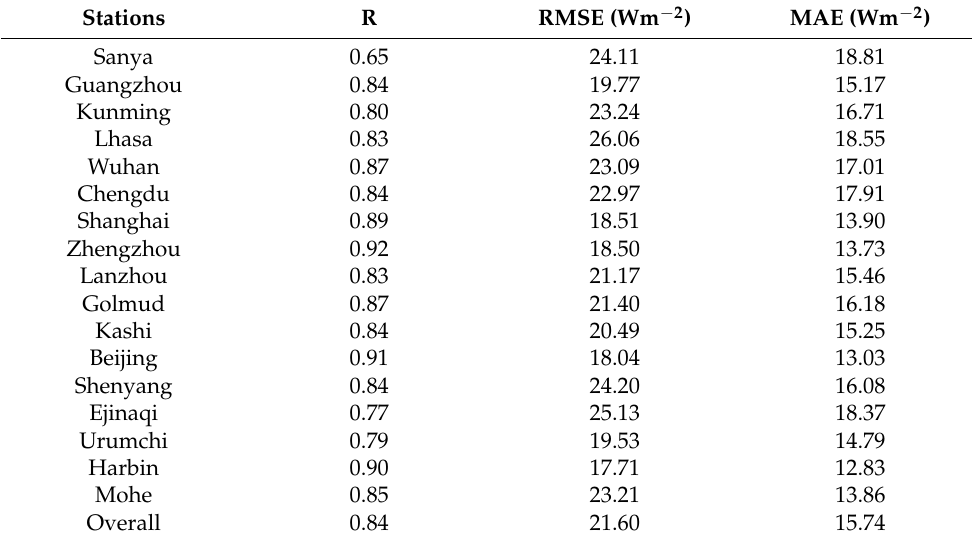
Table 3. Cross-validation for ensemble model (GAM) at different stations.